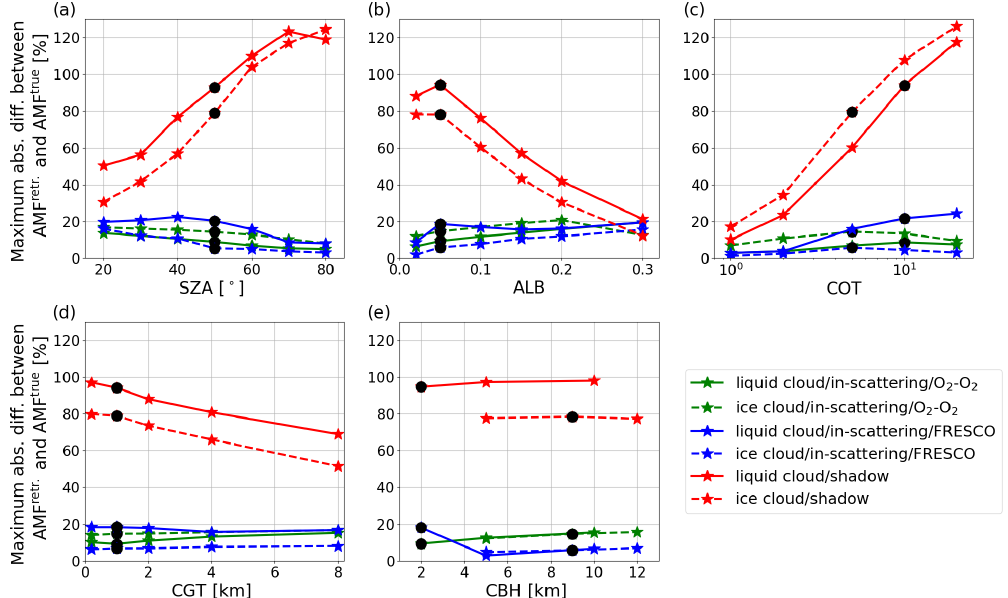
Figure 4. Maximum NO 2 AMF bias for the polluted NO 2 profile in the clear regions as a function of solar zenith angle (a) , surface albedo (b) , cloud optical thickness (c) , cloud geometric thickness (d) , and cloud bottom height (e) . Solid and dashed lines represent the retrieval for the simulations with liquid and ice water clouds respectively. The green and blue lines depict the AMF biases using O 2 –O 2 and FRESCO cloud corrections over the in-scattering region, and the red lines correspond to the retrieval bias in the cloud shadow. Black dots refer to the base cases (SZA = 50 ◦ , ALB = 0 . 05, COT = 10 / 5, CGT = 1km, CBH = 2 / 9km for liquid/ice cloud), which are defined in Sect. 3.1 of Emde et al. (2022).